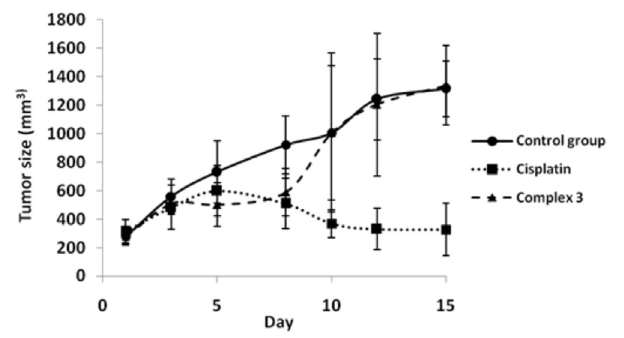
FIGURE 2 - Antitumor effect of complex 3 and cisplatin 4 mg/kg in a mice using model of Ehrlich solid tumor. Results represent the tumor size after treatment (mean ± sd) of different experimental groups (n =